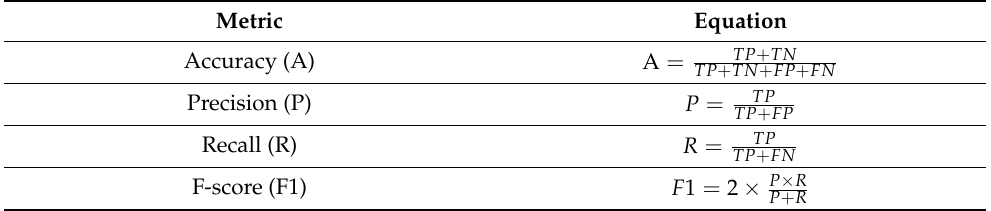
Table 2. Evaluation Metrics.